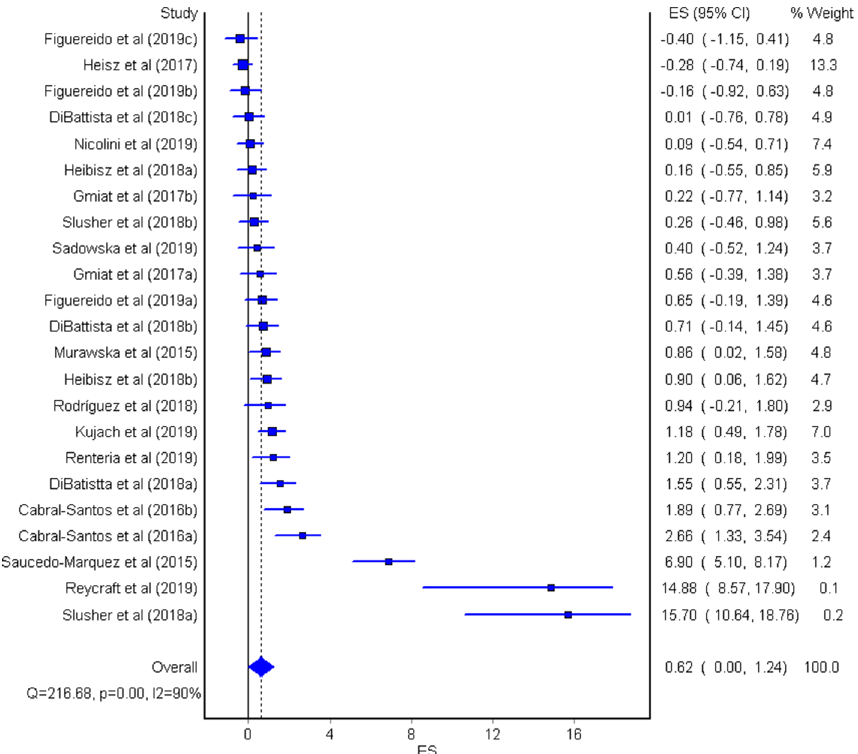
Figure 2. The overall effect of interval training (IT) on peripheral BDNF concentration. The lines indicate 95% confidence intervals (CI), and the square reflects the standardized differences (SMD) for each study. The diamond in the forest plot indicates the overall effect size